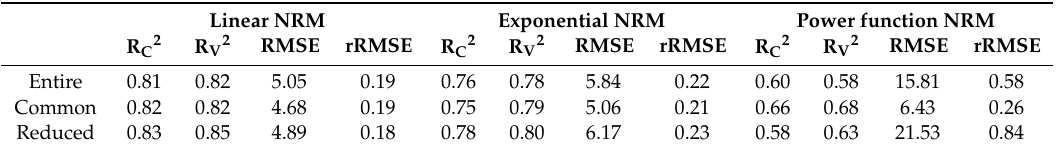
Table 5. Summarized mean values for nitrogen regression models (NRMs) based on crop surface height (Calibration: R C2 : coe ffi cient of determination; Validation: R V2 : coe ffi cient of determination, RMSE: root mean square error (g / kg), rRMSE: relative root mean square error; Entire: entire data set; Common: common N fertilization; Reduced: reduced N fertilization). The statistics for each possible subset combination are shown in the appendix (Table A3).